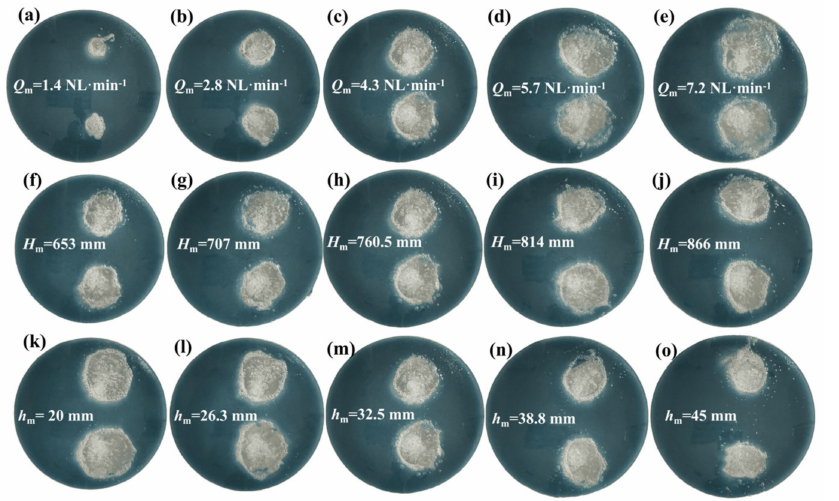
Figure 6. Effect of various factors on SEA at: ( a – e ) gas flow rate; ( f – j ) liquid depth; ( k – o ) slag thickness (Top